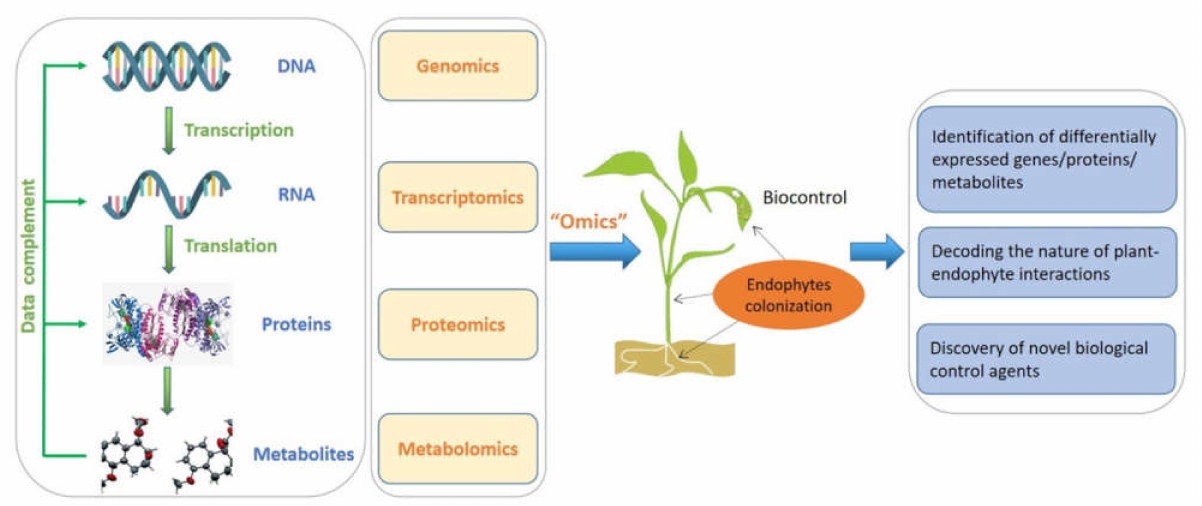
Figure 2. Multi-omics approaches for the research of endophytes and their metabolites in plant disease